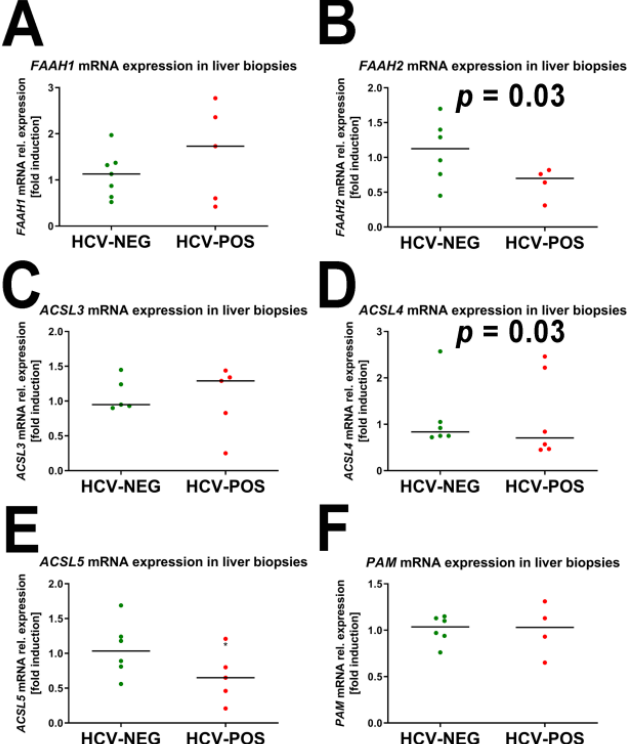
Figure 7. mRNA expression of genes involved in FAA metabolism. ( A ) Fatty acid amide hydrolase 1 ( FAAH1 ); ( B ) Fatty acid amide hydrolase 2 ( FAAH2 ); ( C ) Acyl-CoA synthetase long chain family member 3 ( ACSL3 ); ( D ) Acyl-CoA synthetase long chain family member 4 ( ACSL4 ); ( E ) Acyl-CoA synthetase long chain family member 5 ( ACSL5 ); ( F ) Peptidylglycine alpha-amidating monooxygenase ( PAM ).